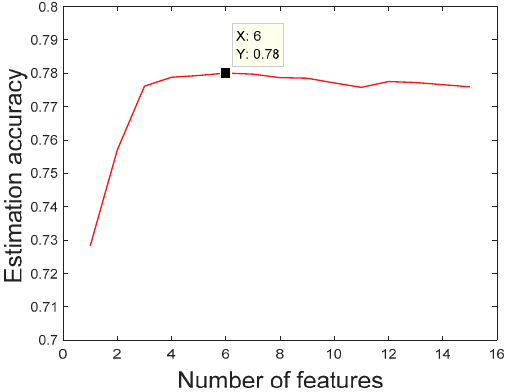
Figure 2. Relation between insect mass estimation accuracy and the number of features. Note: the number of features was selected based on the importance ranking. number of features was selected based on the importance